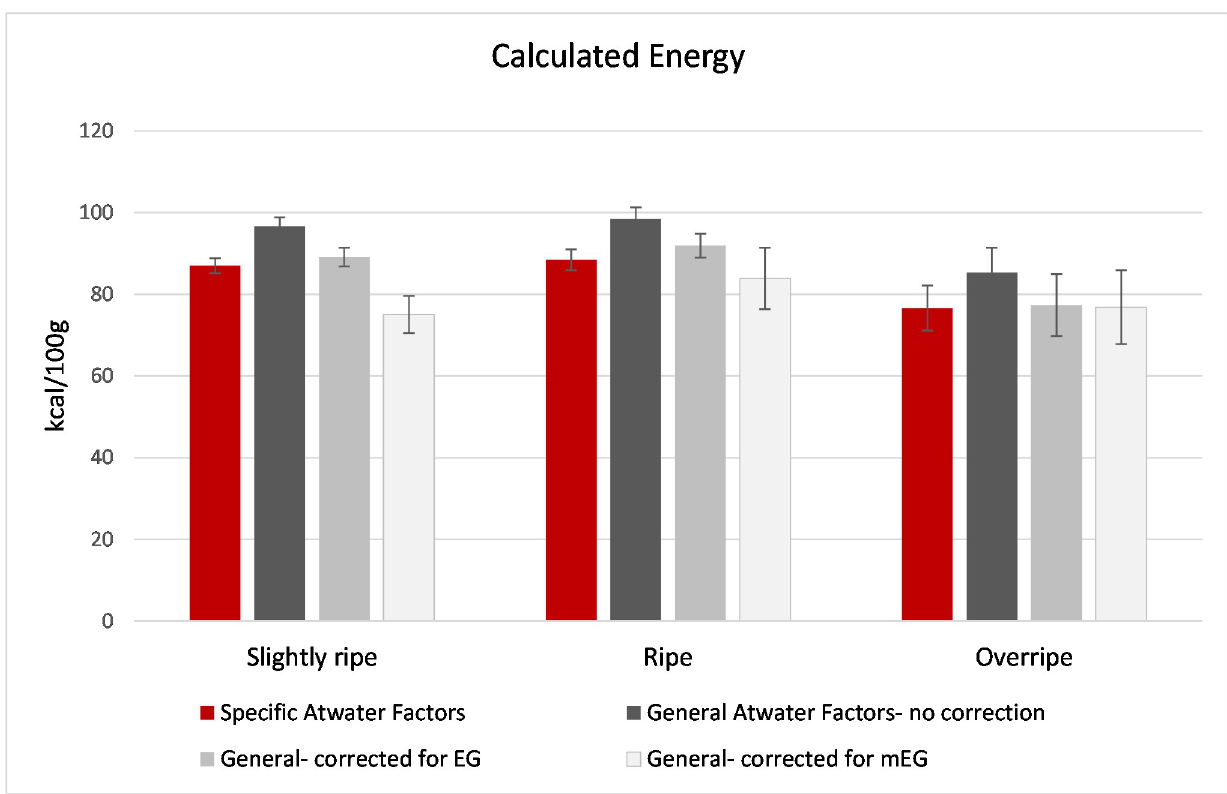
Fig 5. Mean energy content of bananas of different ripeness in the retail study, calculated from proximate data (Table 2) using either the specific or general Atwater factor for carbohydrates by difference (3.6 and 4 and kcal/g, respectively) [87], with and without subtracting EG fiber or mEG fiber (see Table 2) from total carbohydrates by difference before applying the general factor. Error bars show the range for 6 samples at each stage of ripeness.